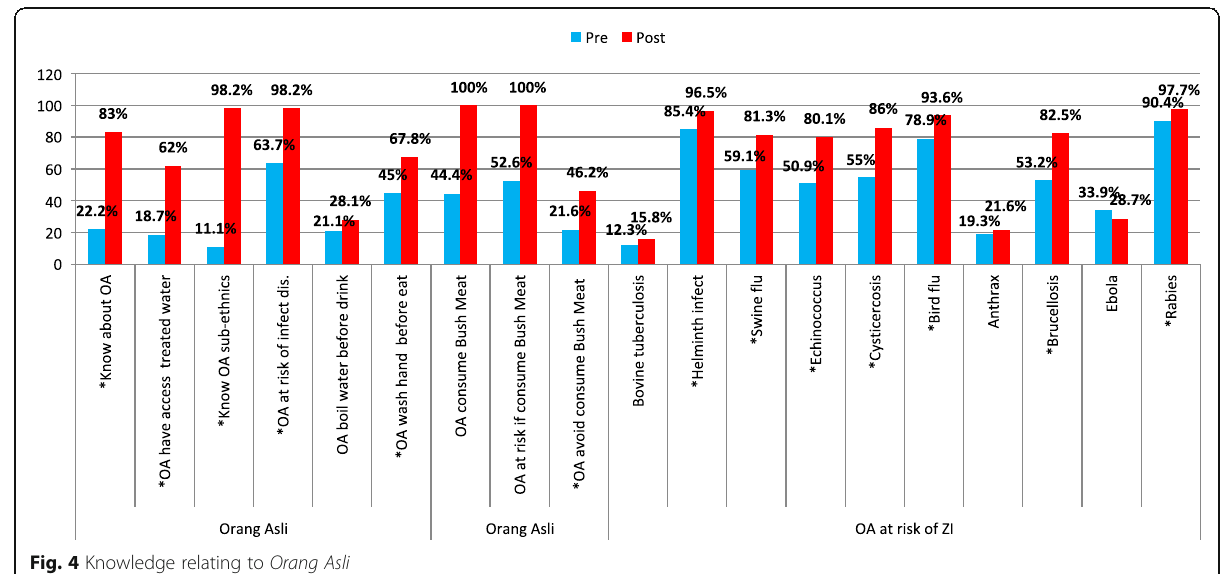
Fig. 4 Knowledge relating to Orang